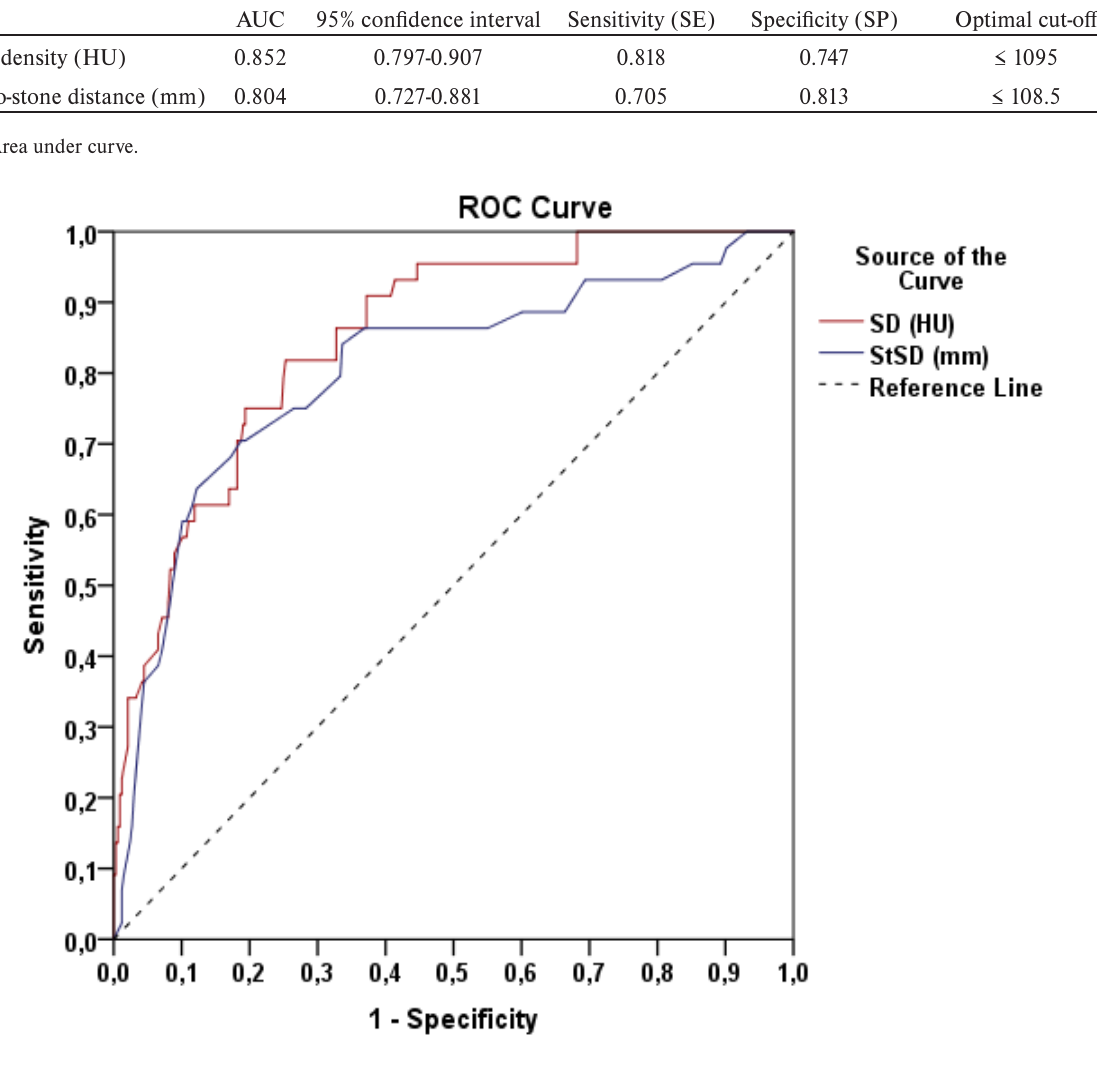
Fig. 1. ROC analysis. According to ROC analysis, the optimal cut off for skin-to-stone distance (StSD) is ≤ 108.5 mm and optimal cut off for stone density (SD) is ≤ 1095 Hountfield units